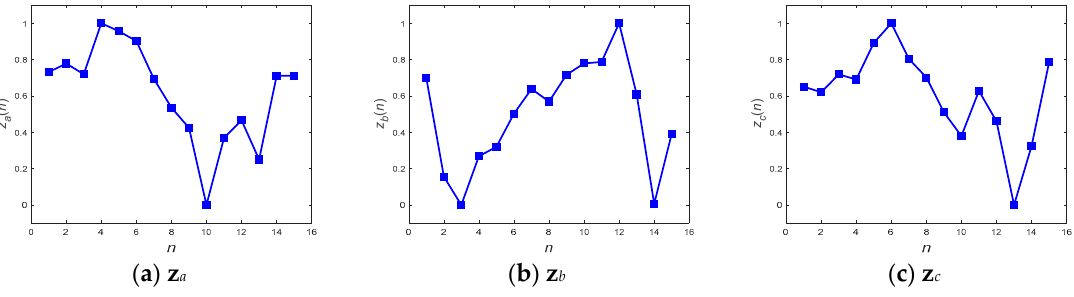
Figure 11. DFT interpolation preprocessed sequences z a , z b , and z c from inputs x a , x b , and x c , respectively.